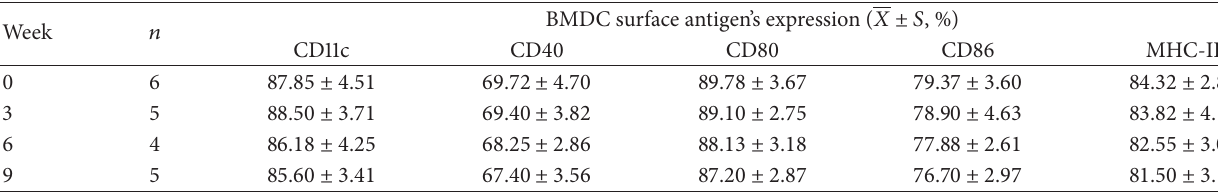
Table 2: BMDC surface antigen’s expression of OVA group.